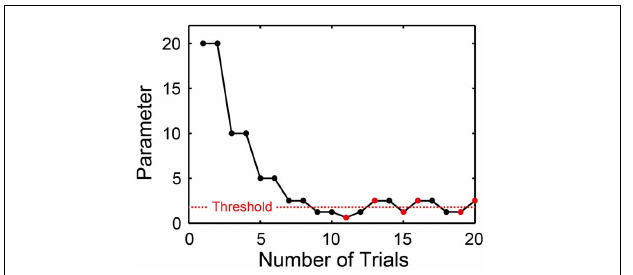
FIGURE 8 | Two-down one-up stair-case method used in beat saliency test (BST), beat interval test (BIT), and beat finding and interval test (BFIT). The parameter was halved when the pattern of the stimulus matched with the participant’s response twice consecutively, while doubled otherwise. Every time the direction of parameter change reversed from down to up or from up to down, the parameter at which this occurred was recorded as turnaround point (marked by red). We calculated the average across the six turnaround points and defined it as a threshold (horizontal dashed line).